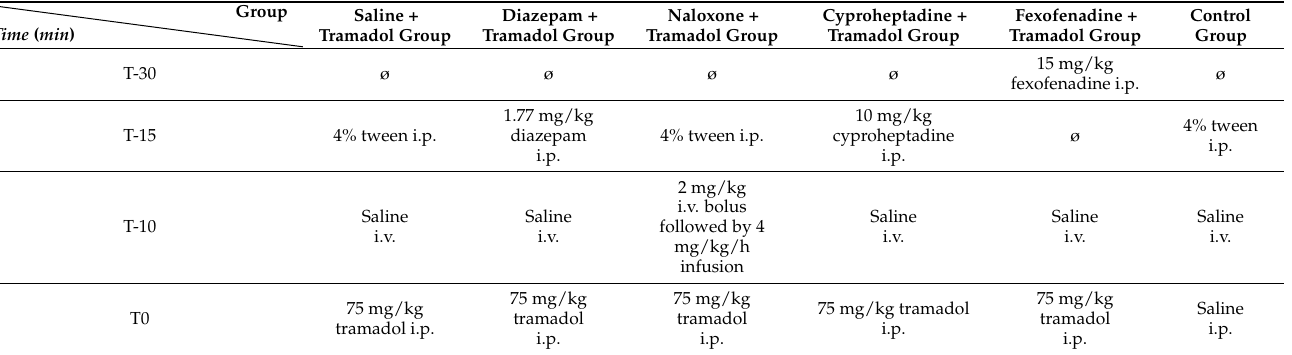
Table 1. Treatments administered in the different study